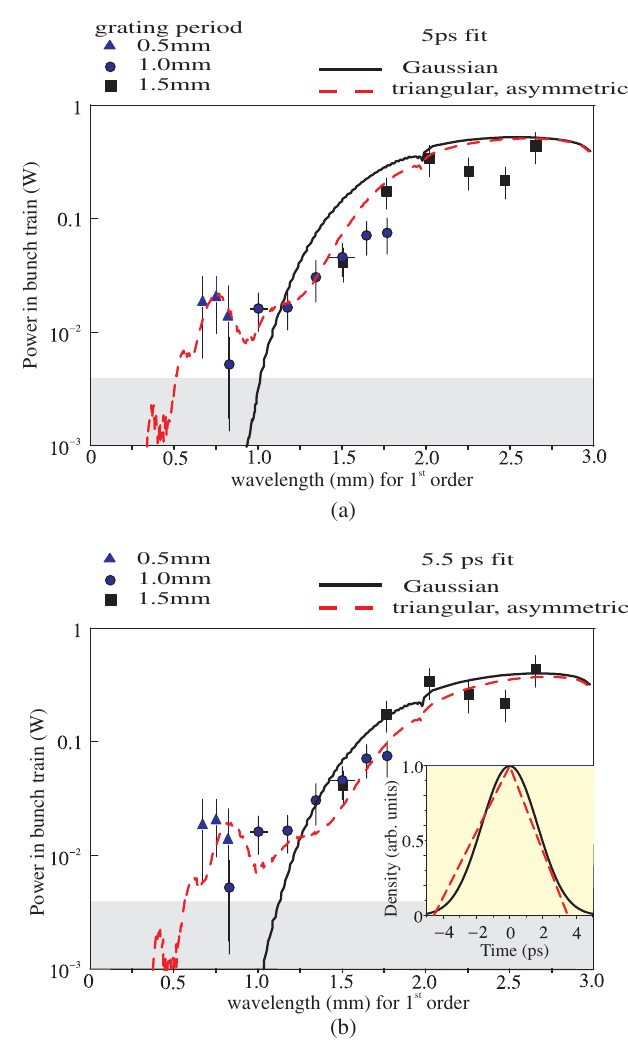
FIG. 9. (Color) The data points of Fig. 7 fitted with a Gaussian and an asymmetric triangular profile, with 90% of the particles contained inside (a) 5 ps and (b) 5.5 ps. The inset in (b) shows these two bunch